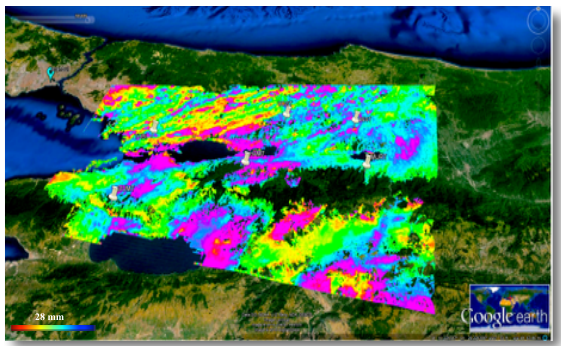
Table 1: Information on SAR satellite images used in this study.